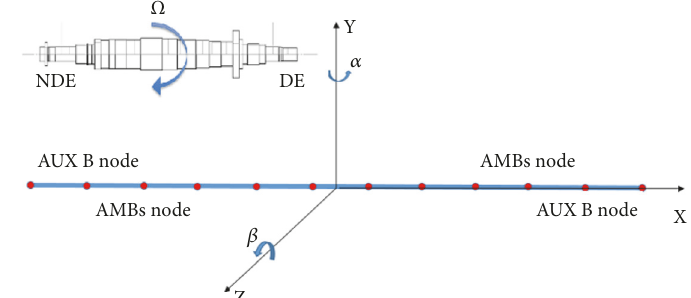
Figure 3: Discretization of the rotor in 2D BEAM elements.